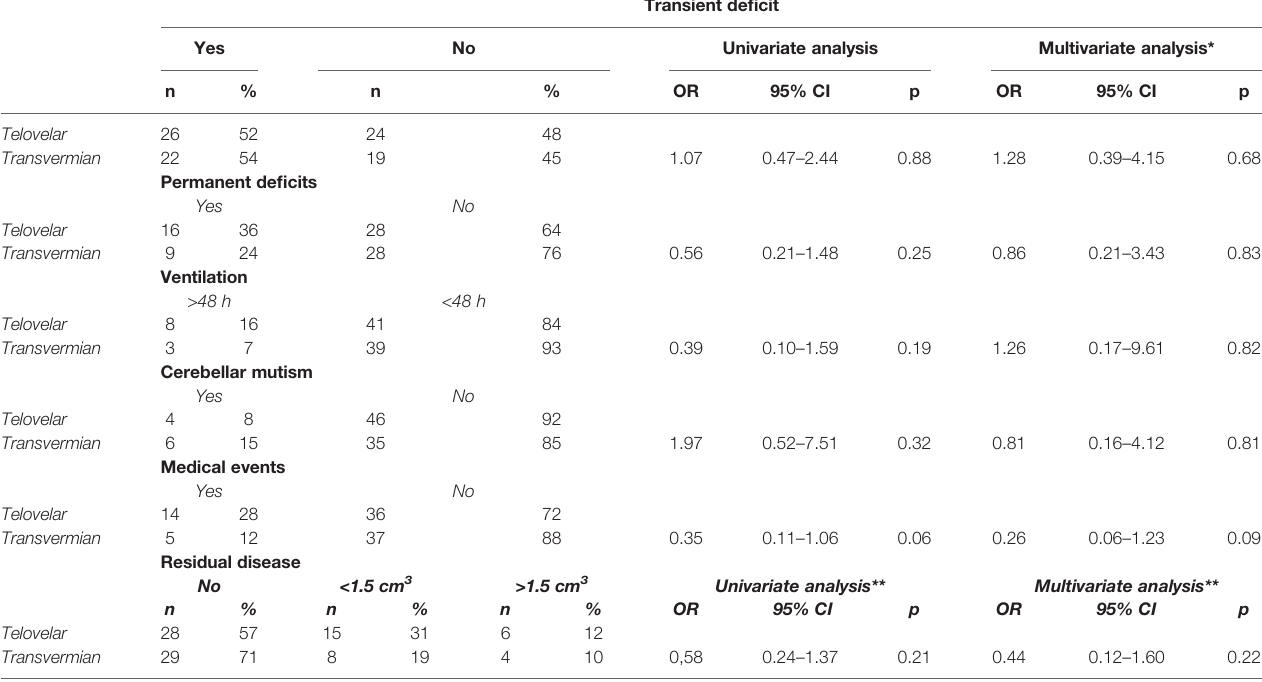
TABLE 3 | Surgical approach and postoperative